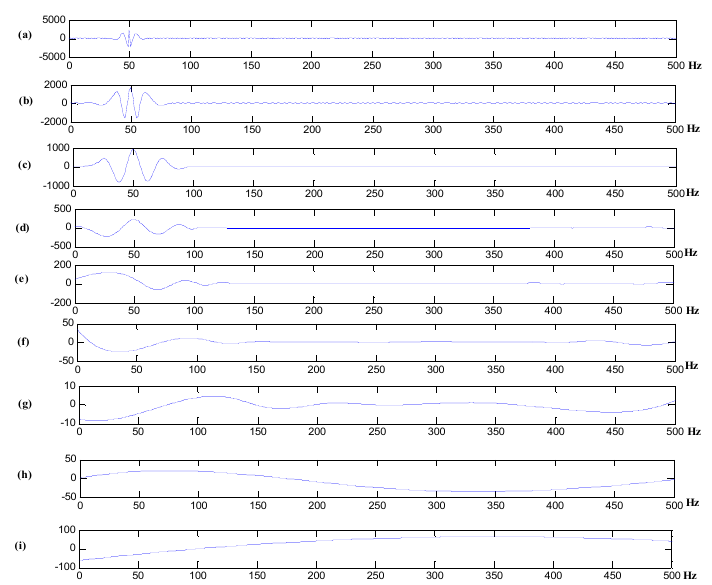
Figure 9. Empirical mode decomposition results from the simulated signal. Note: ( a – i ) represent the eigenmode functions (IMFs) after signal decomposition, respectively.